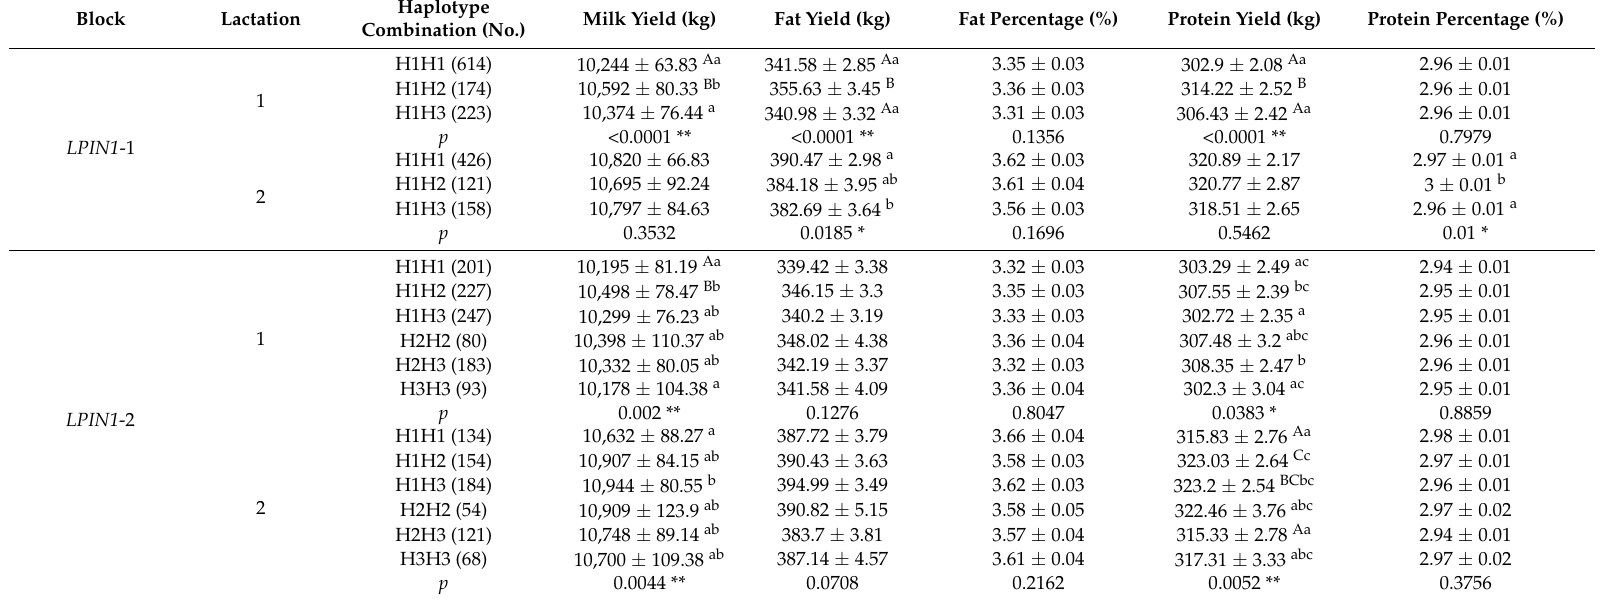
Table 3. Associations of haplotype blocks with milk production traits in two lactations in Chinese Holstein (LSM ± SE). Haplotype Block Lactation Combination